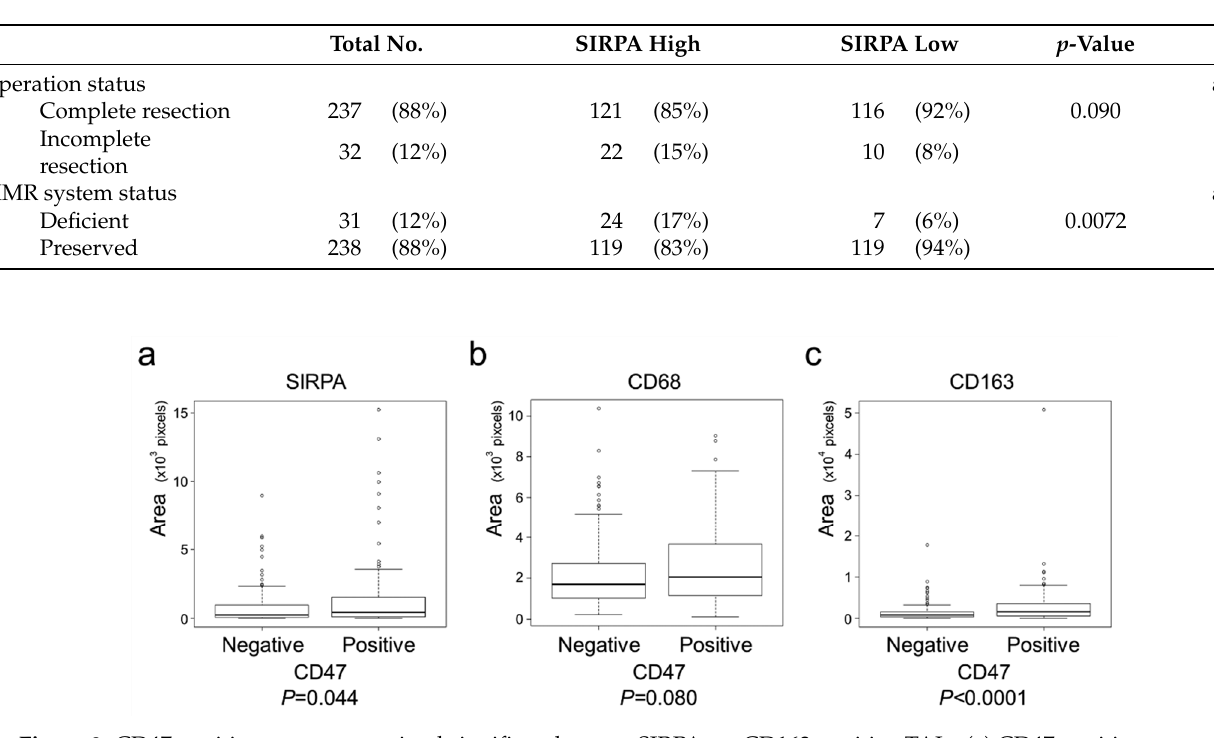
Figure 3. CD47-positive tumors contained significantly more SIRPA- or CD163-positive TAIs. ( a ) CD47-positive tumors contained significantly more SIRPA-positive TAIs ( p = 0.044). ( b ) CD47-positive tumors tended to contain more CD68- positive TAIs ( p = 0.080). ( c ) CD47-positive tumors contained significantly more CD163-positive TAIs ( p < 0.0001). This is a figure. Schemes follow another format.